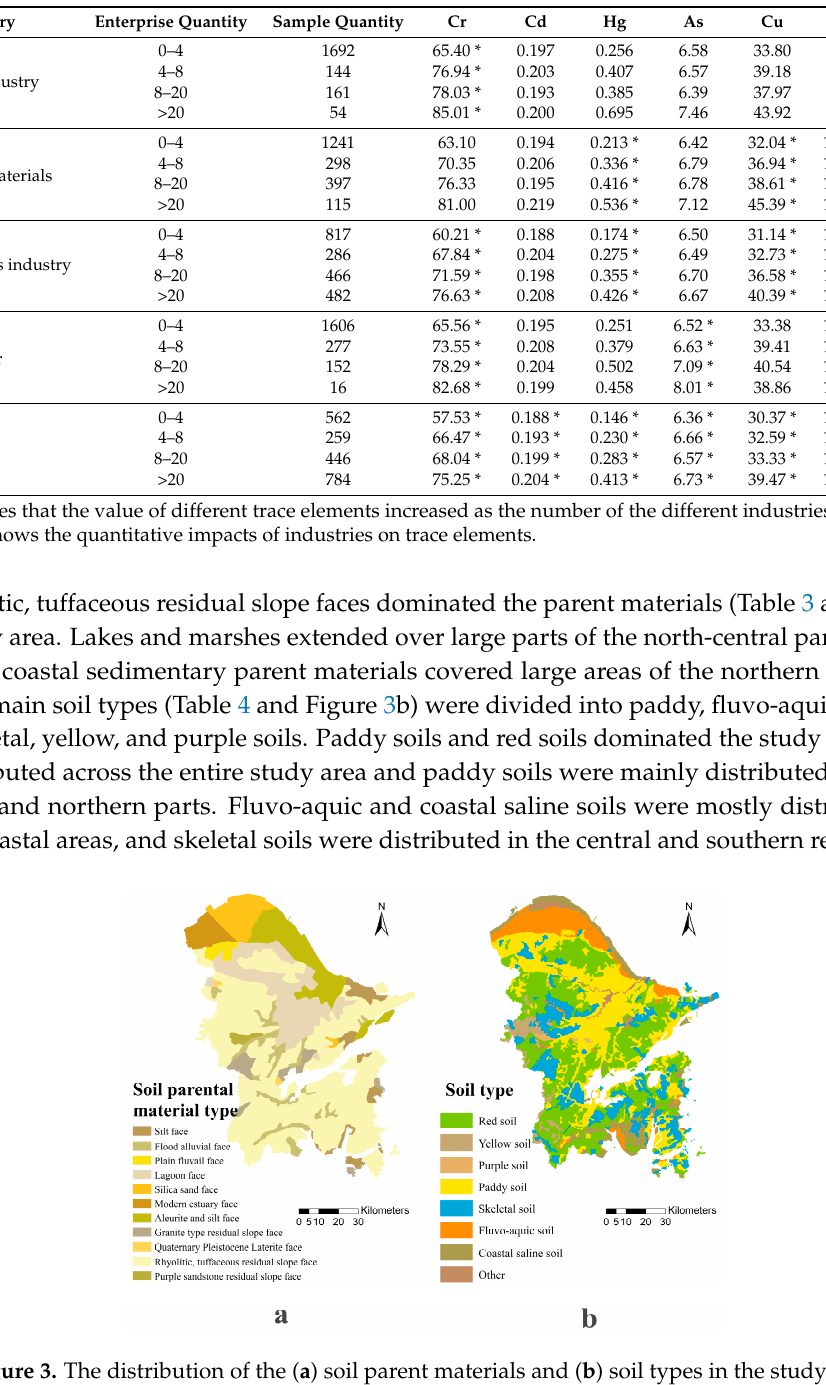
Table 5. Values of the SPI for different trace elements. Element